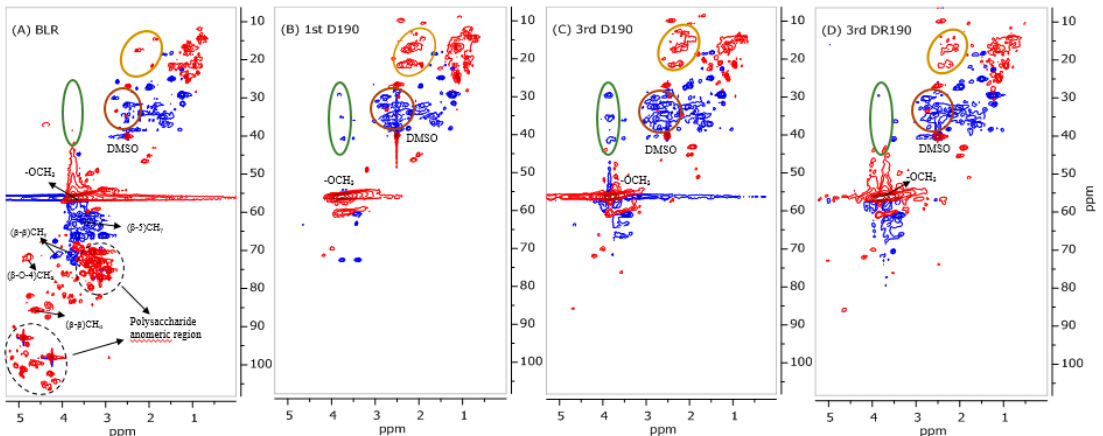
Figure 4. The lignin side-chain and the aliphatic region of 2D HSQC NMR spectra of the heavy fractions from ( A ) BLR, ( B ) first 190 ◦ C depolymerized BLR (D190), ( C ) third 190 ◦ C depolymerized BLR (3 rd D190), and ( D ) third 190 ◦ C depolymerized retentate after two rounds of depolymerization and two rounds of membrane separation (3rd DR190).